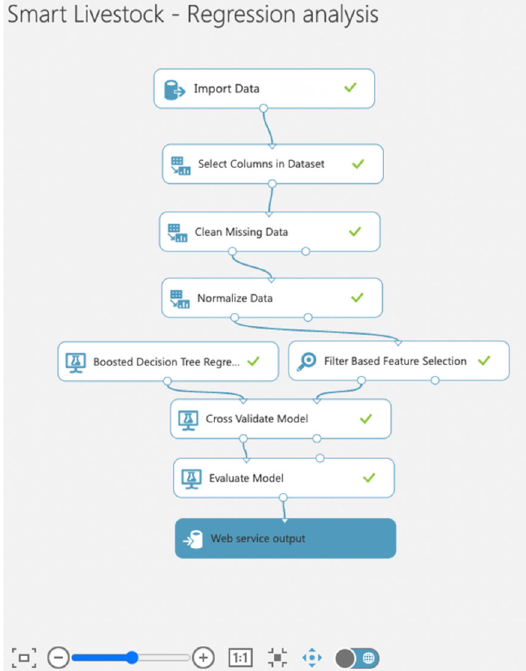
Figure 13. Azure Machine Learning workflow.